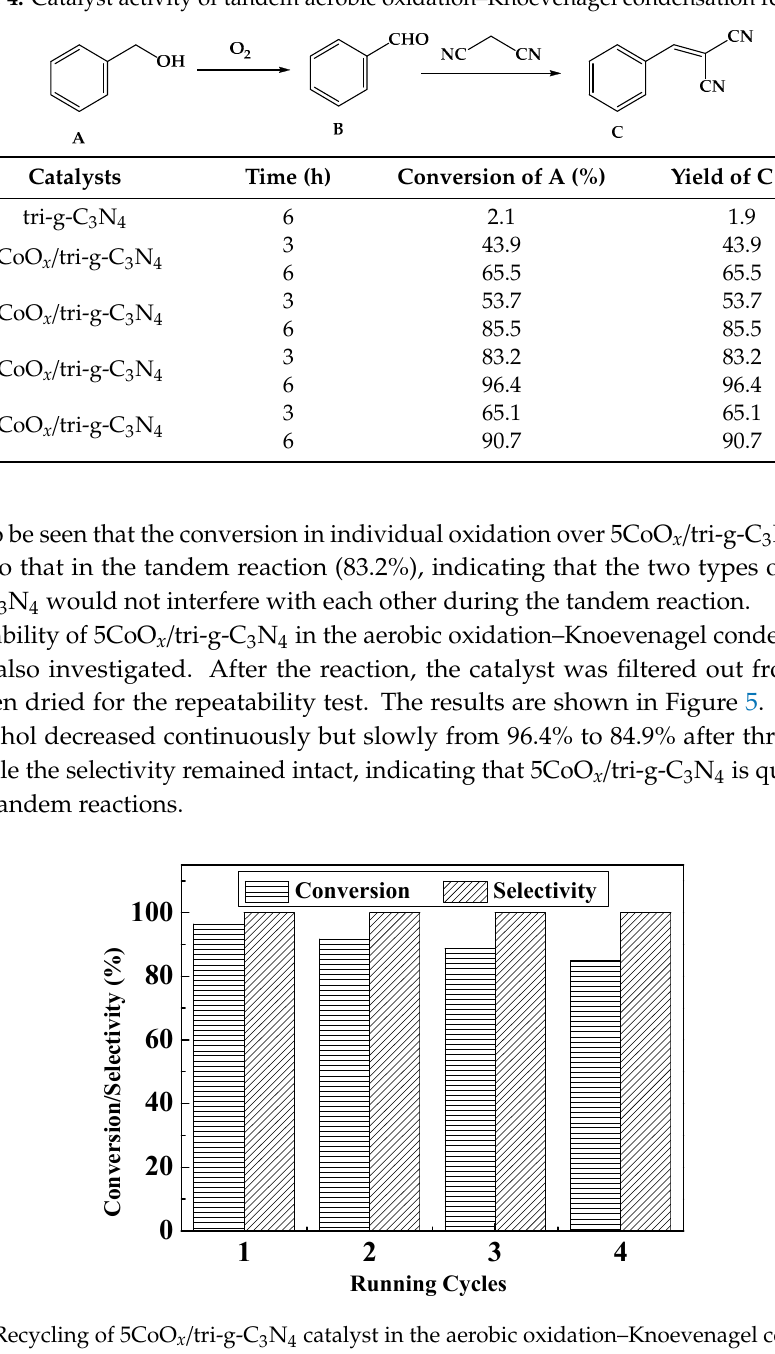
Running Cycles Figure 5. Recycling of 5CoO x /tri-g-C 3 N 4 catalyst in the aerobic oxidation–Knoevenagel condensation Figure 5. Recycling of 5CoO x / tri-g-C 3 N 4 catalyst in the aerobic oxidation–Knoevenagel condensation tandem reaction. tandem